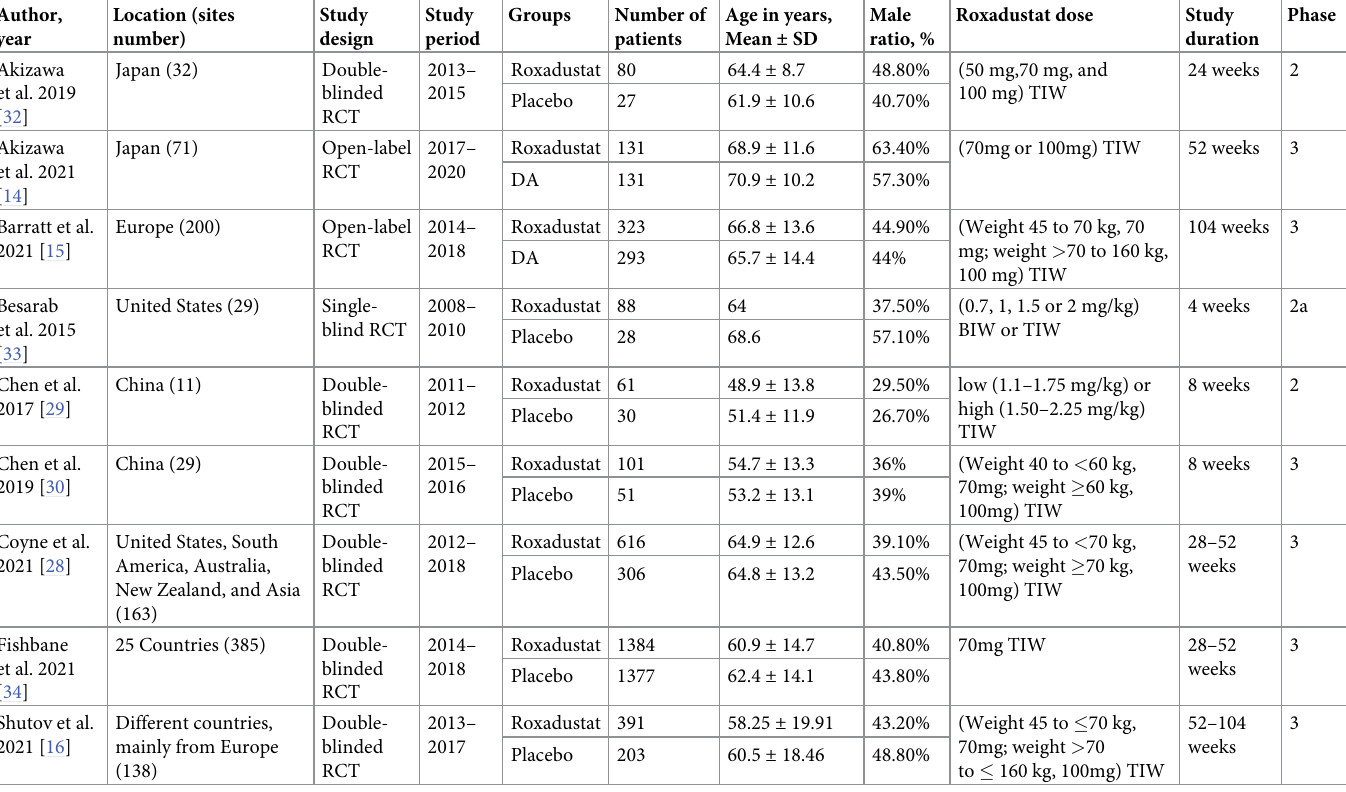
Table 1. Characteristics of the included